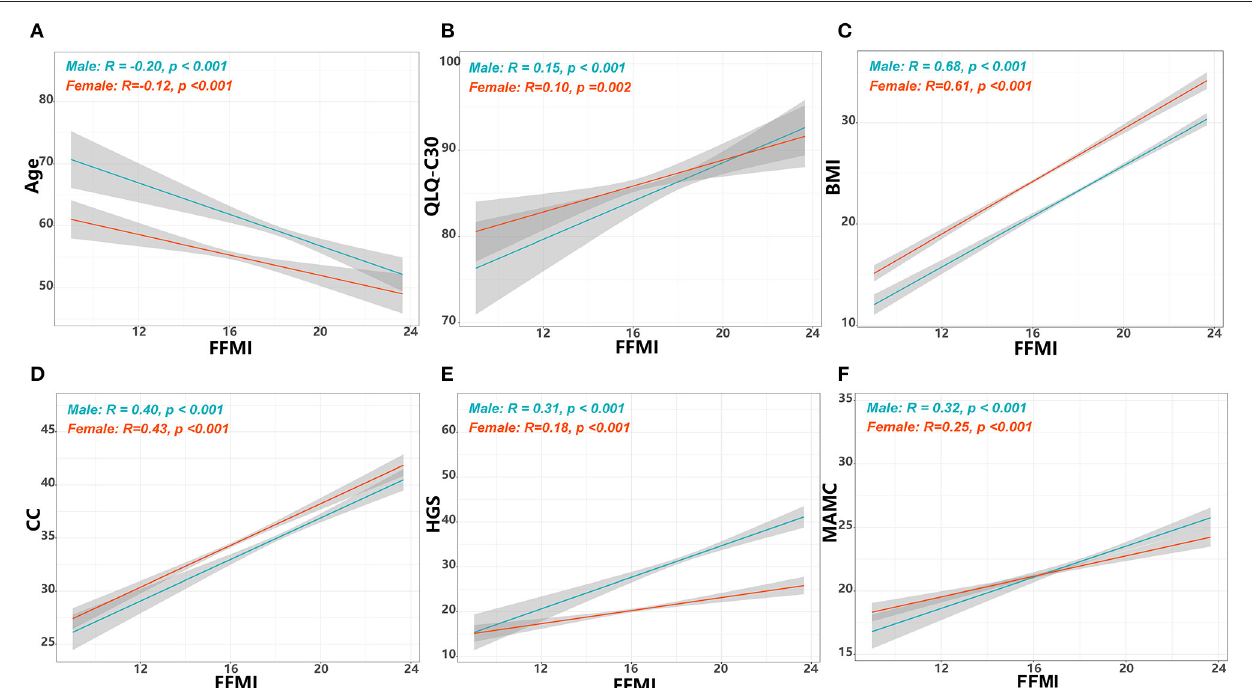
FIGURE 1 | Correlations of FFMI with age, summary score of QLQ-C30 and anthropometric measurements. The correlations of FFMI with age (A) , summary score of QLQ-C30 (B) , BMI (C) , CC (D) , (E) HGS, and MAMC (F) . FFMI, fat free mass index; BMI, body mass index; CC, calf circumference; MAMC, mid-arm muscle circumference; HGS, hand grip strength; QLQ-C30, Quality of Life Questionnaire.